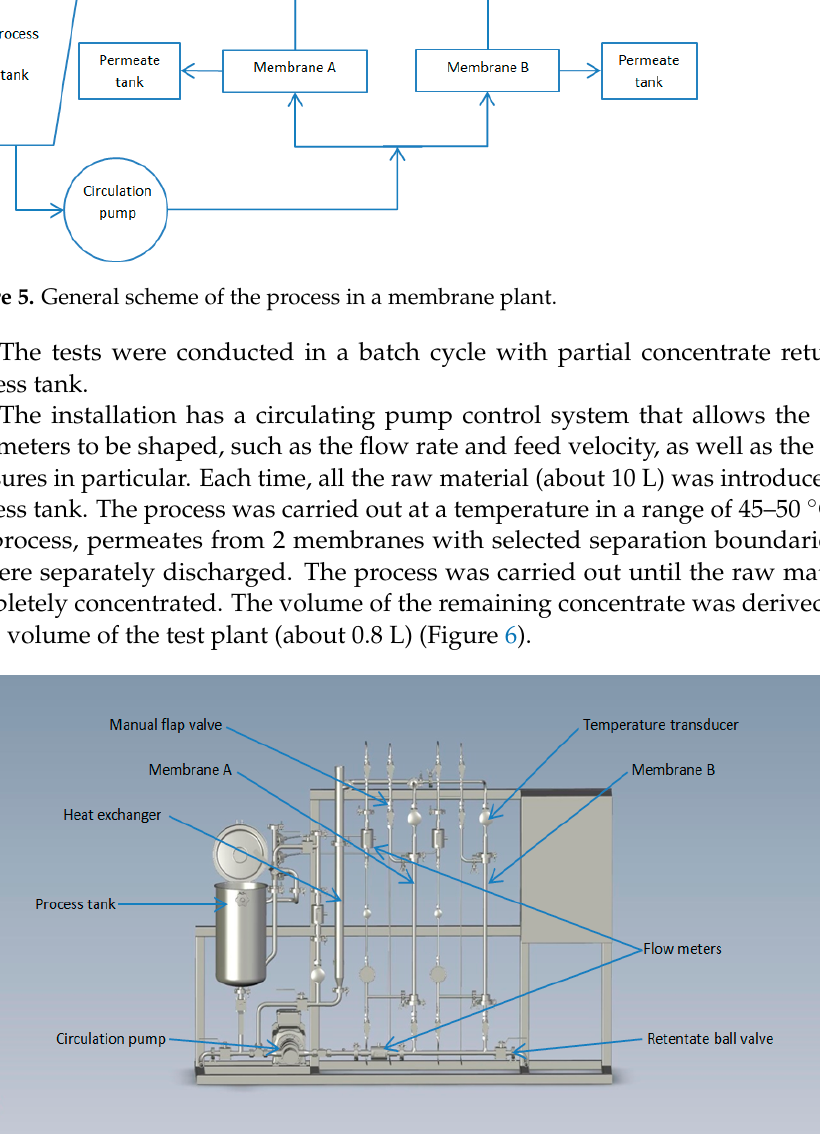
10 of 16 Table 6. Parameters of the liquid fraction. Technical Parameter